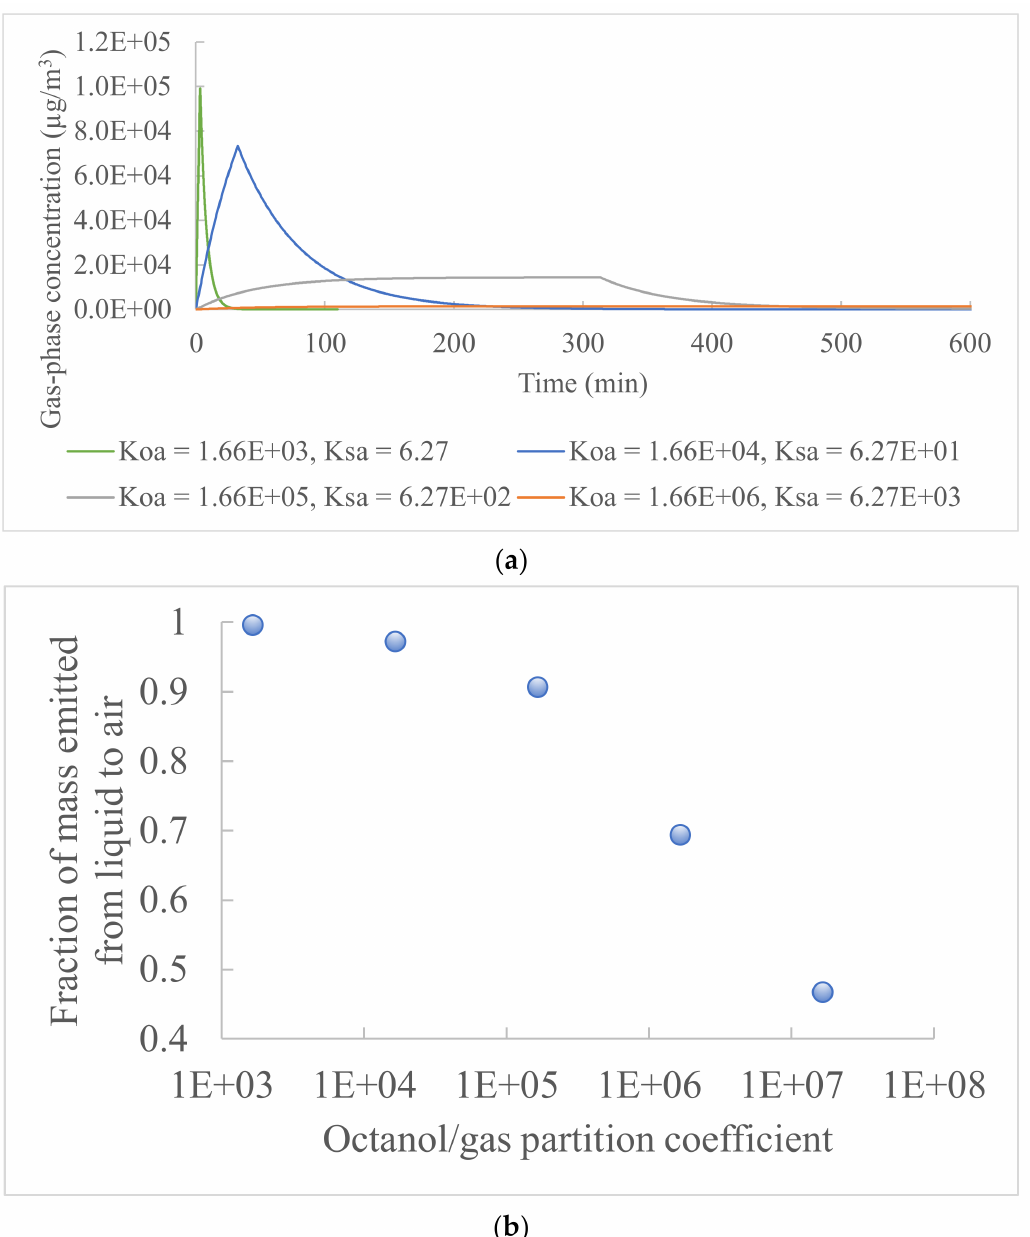
Figure 4. Influence of octanol/gas and material/gas partition coefficients ( K oa and K sa ) on the chemical indoor gas-phase concentration: ( a ) concentration profile and ( b ) fraction of mass emitted from the product liquid to